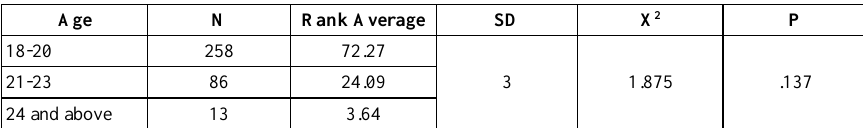
Table 8. Distance education status by age